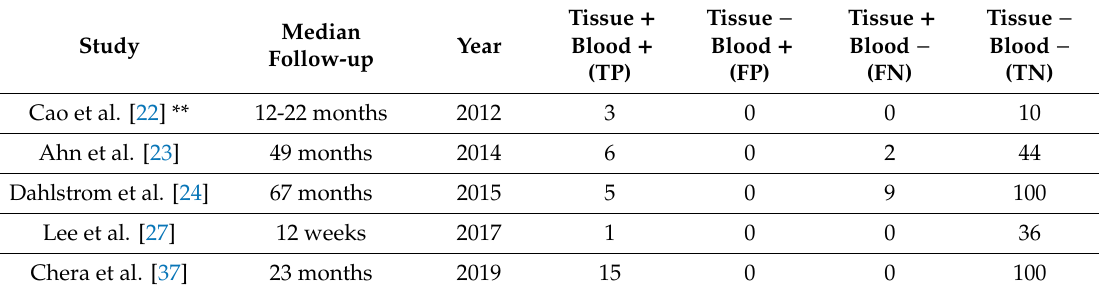
Table 3. Studies included in the meta-analysis of follow-up stating relapse of HPV-related OPSCC according to tissue and blood sample